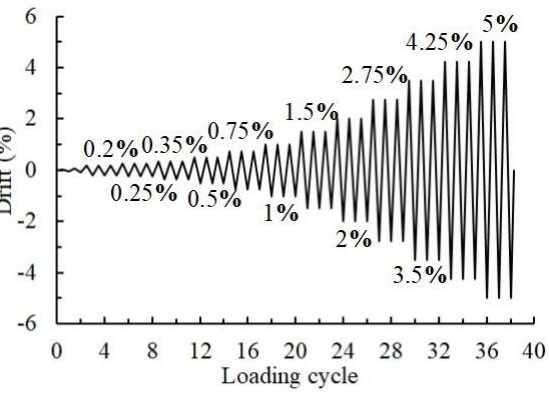
Figure 5. Loading sequence [9].